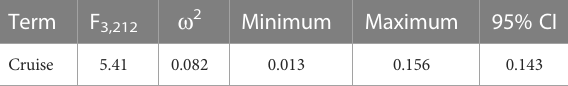
TABLE 5 F-test, effect size ( w 2 ), minimum, maximum, and 95% con fi dence interval for the “ cruise ” factor in a one-way ANOVA for the LMW/HMW